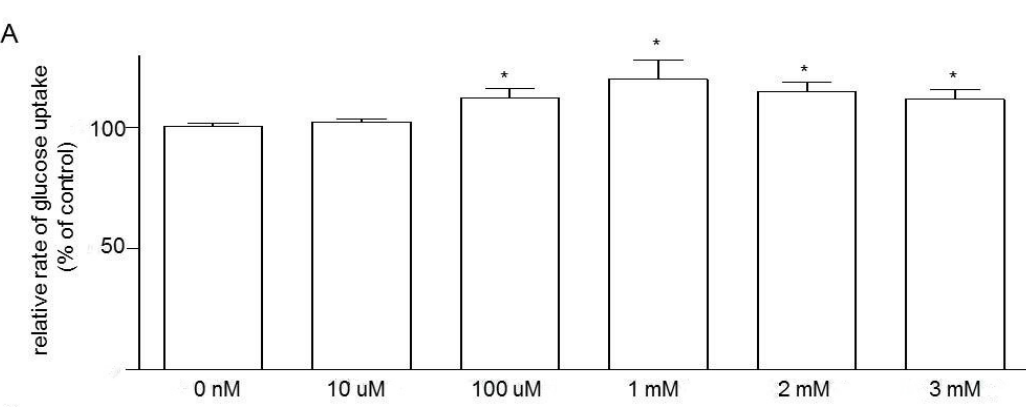
Figure 4. ( A ) Effects of high glucose concentration (25.2 mM) on the mRNA expression of GPR109a in Caco-2 cells vs. low glucose concentration (5.6 mM). Results are expressed as means ± standard error of the mean (SEM), n = 3, control = 5.6 mM glucose, control vs. 25.2 mM glucose, * p < 0.05; ( B ) Effects of high glucose (25.2 mM) on GPR109a protein expression in Caco-2 cells vs. control 5.6 mM glucose concentrations. Results are expressed as means ± SEM, n = 6, control = 5.6 mM vs. 25.2 mM, * p < 0.05.